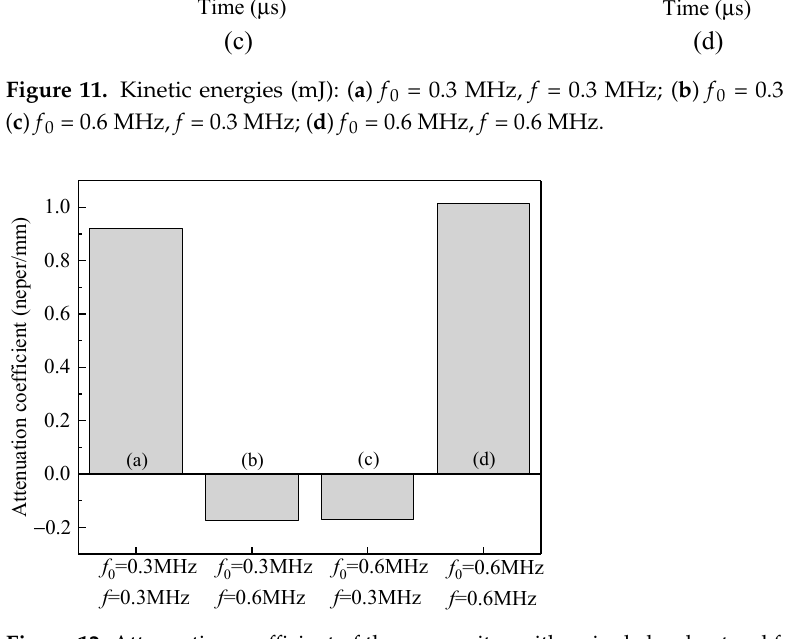
Figure 12. Attenuation coefficient of the composites with a single local natural frequency of particles: ( a ) f 0 = 0.3 MHz, f = 0.3 MHz; ( b ) f 0 = 0.3 MHz, f = 0.6 MHz; ( c ) f 0 = 0.6 MHz, f = 0.3 MHz; ( d ) f 0 = 0.6 MHz, f = 0.6 MHz.